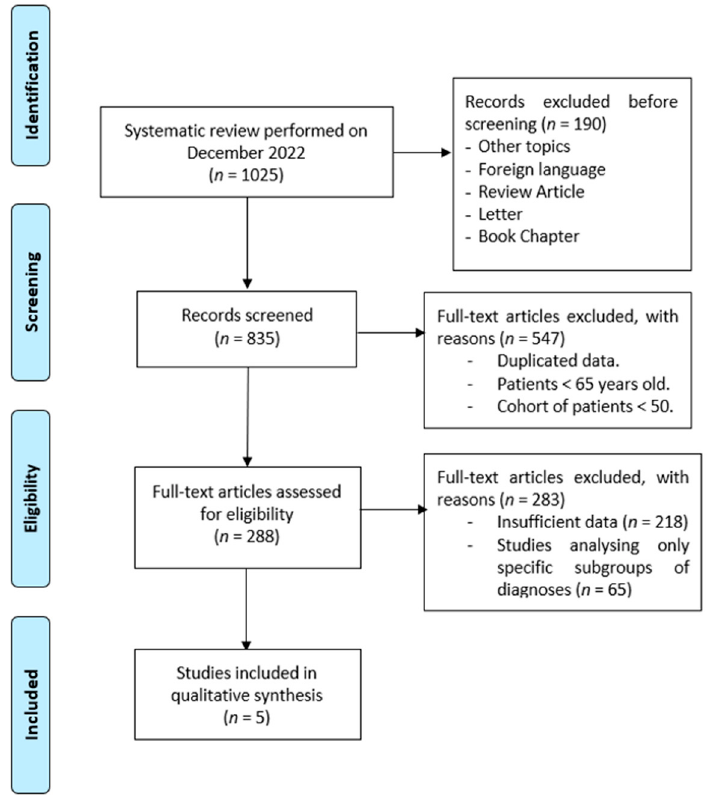
Figure 1. Literature evaluation and selection, according to PRISMA criteria (http://www.prisma- statement.org/).